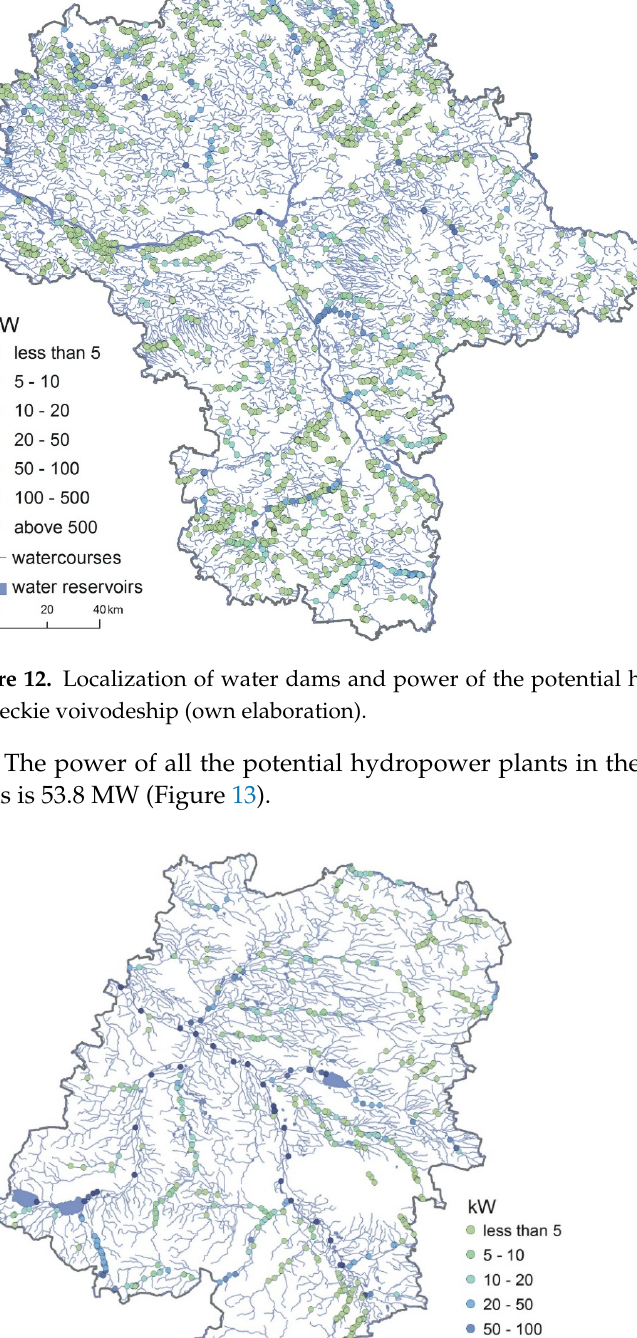
Figure 14. Localization of water dams and power of the potential hydropower plants in the Pod- karpackie voivodeship (own elaboration).